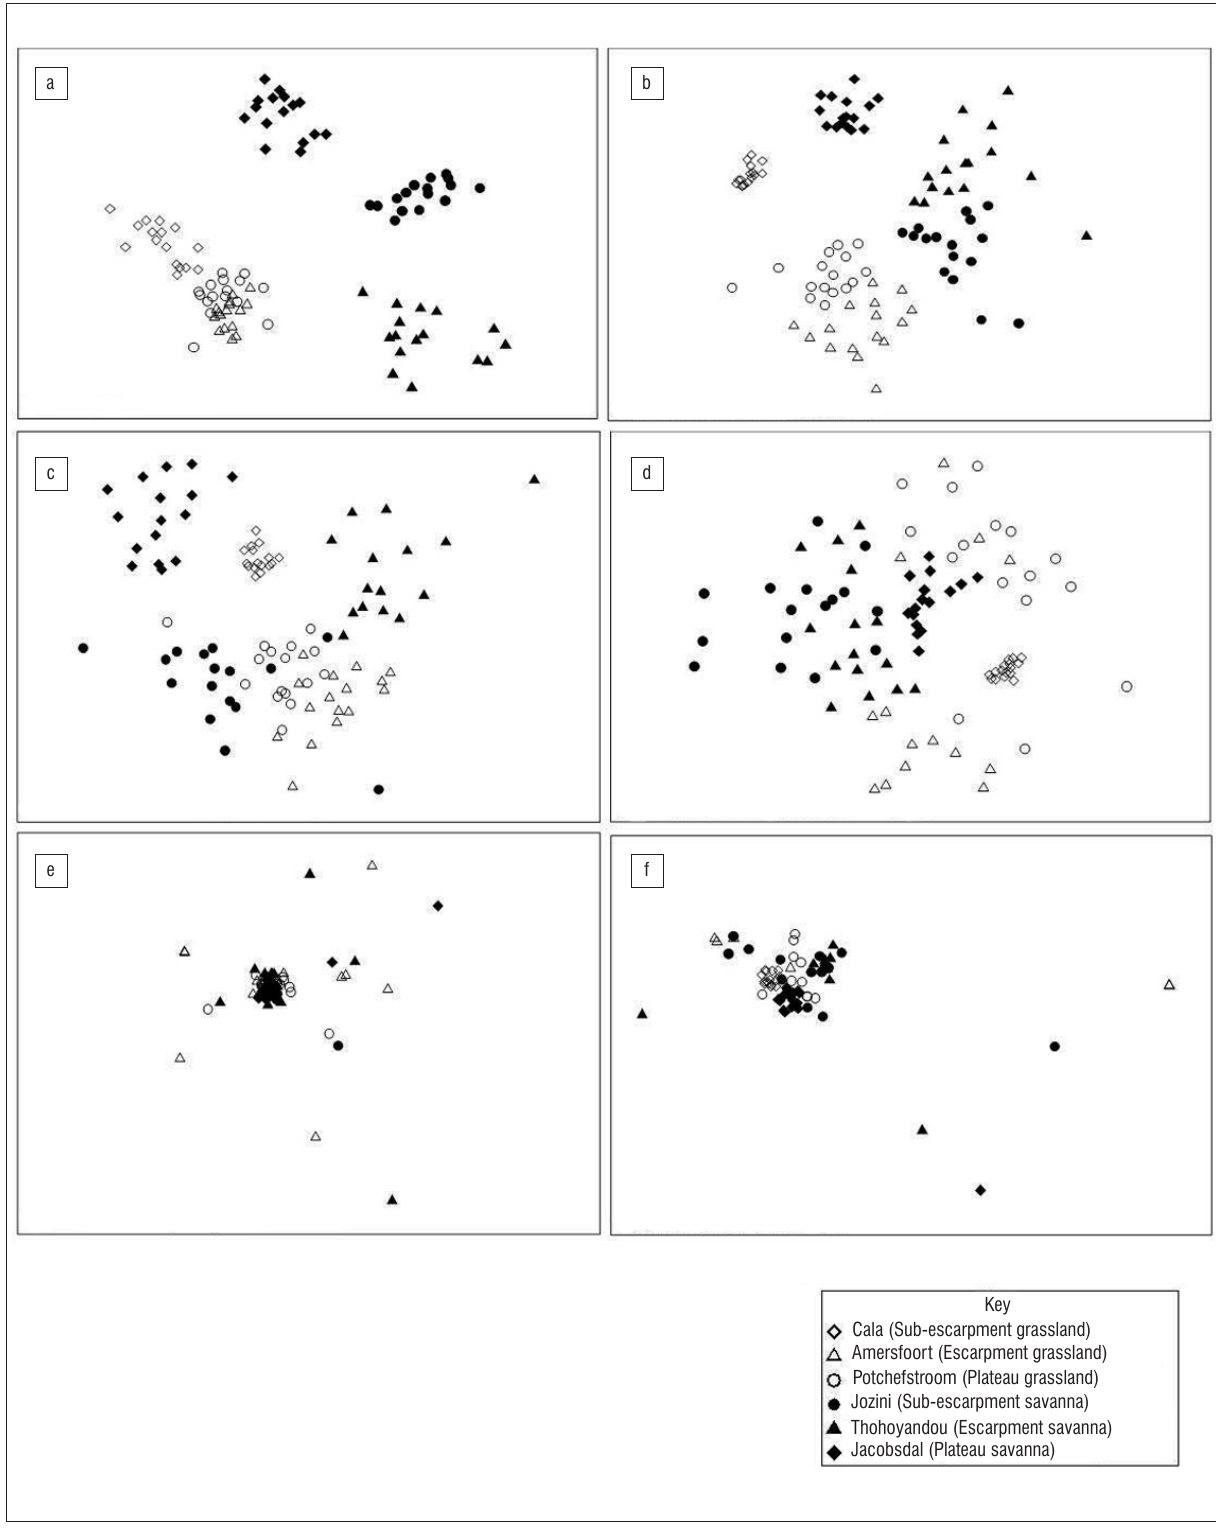
Figure 3: Non-metric multidimensional scaling (NMDS) analyses based on abundance data of plant and arthropod species recorded at maize field margin localities for (a) all plant species, 2D Stress: 0.14, (b) all arthropod species, 2D Stress: 0.23, (c) herbivorous arthropods, 2D Stress: 0.17, (d) predatory arthropods, 2D Stress: 0.16, (e) parasitoid arthropods, 2D Stress: 0.01, and (f) pollinators, 2D Stress: 0.01. Resemblance: S17 Bray– Curtis similarity; data transformation: square